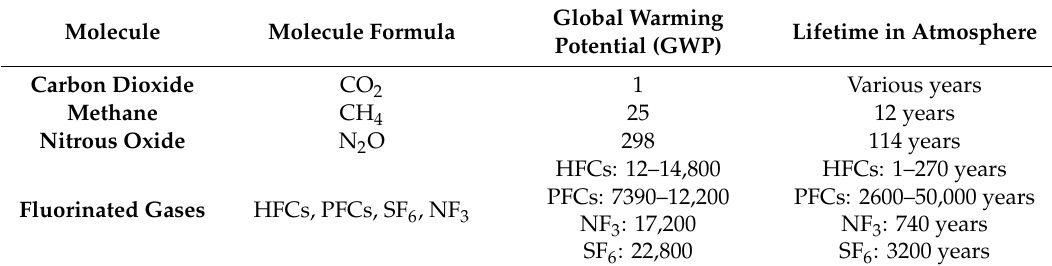
Table 1. Gases with the highest global warming potential (GWP)